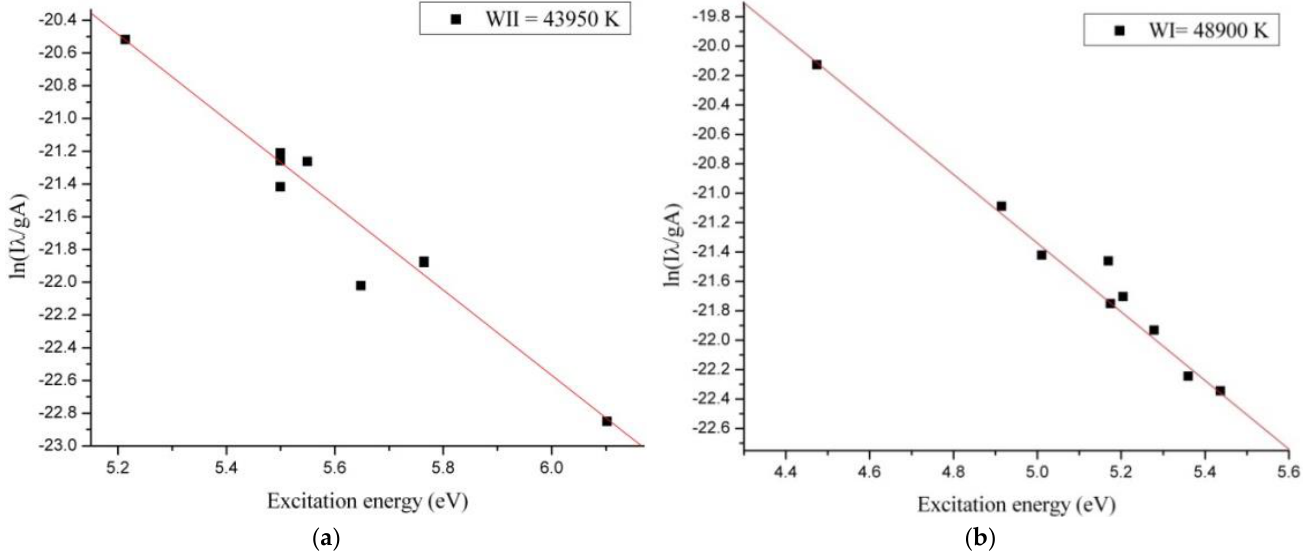
Figure 5. Boltzmann Plot for ( a ) WI in the air at normal pressure and ( b ) for WII in air at normal pressure.